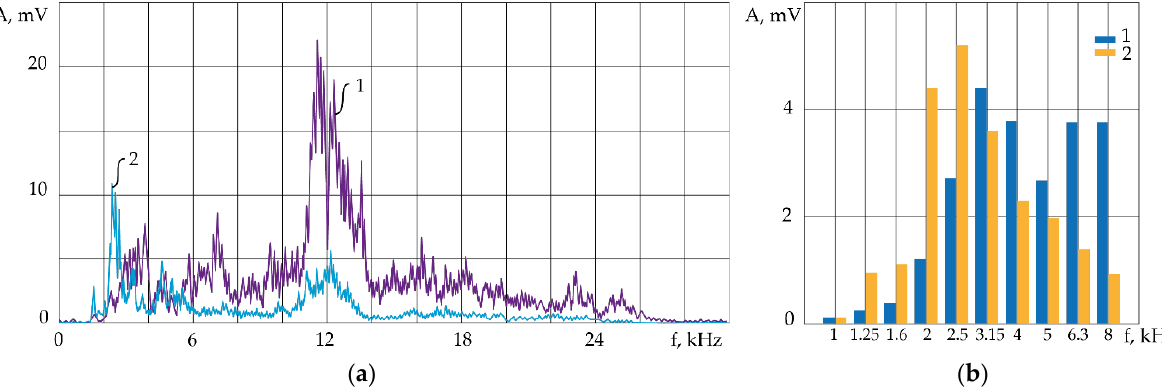
Figure 4. Comparison of the spectra of AE signals during the processing of hard alloy: the beginning of cutting (1) and just before the breakage of the wire electrode (2): ( a ) detailed amplitude spectra; ( b ) 1/3 octave bands with numbers showing the central frequencies of 1/3 octave bands.